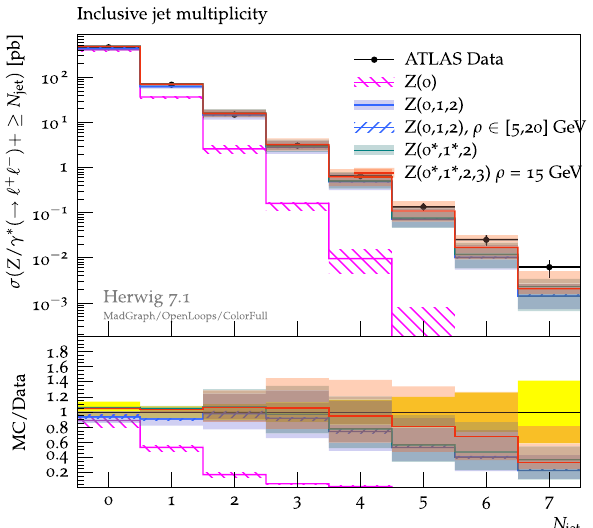
Fig. 22 JetmultiplicitiesasmeasuredbyATLAS[70]comparedtoour simulation. The LO+PS Z ( 0 ) as well as the not included Z ( 0 , 1 ) fail to describe higher jet multiplicities. Inclusion of merged samples with at least two additional jets construct back-to-back configurations and open the phase space for emissions of multiple hard jets. The inclusion of MEs with three additional hard jets describe the higher multiplicities more appropriate, although the scale uncertainties are rather large here